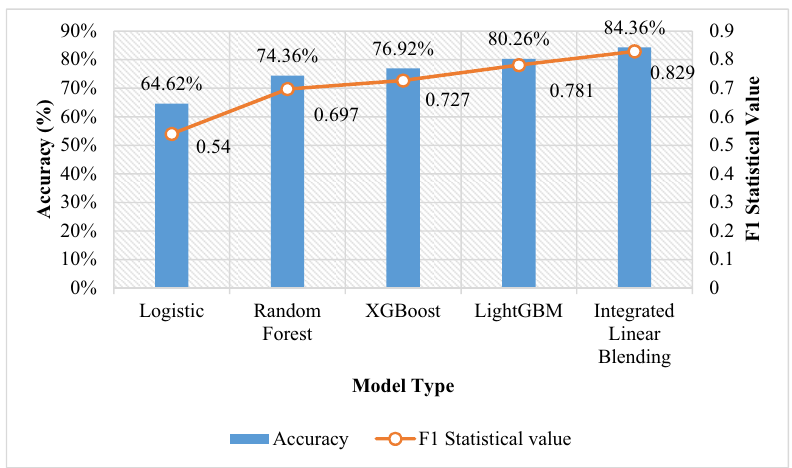
Figure 6: Comparative analysis of accuracy and F 1 statistical